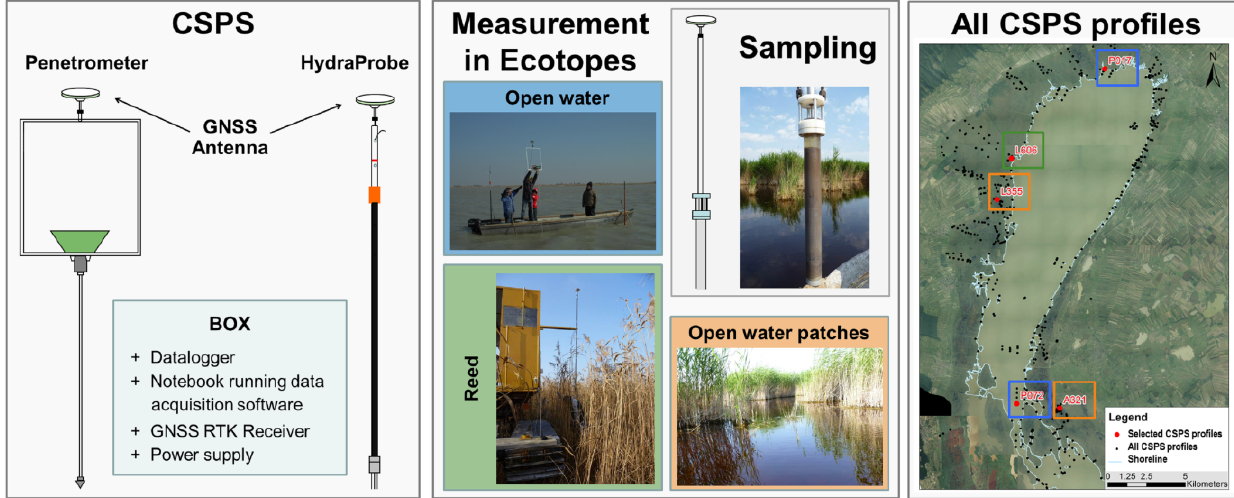
Figure 1. Overview showing the designed system (CSPS), the measurement in the different ecotopes in representative pictures, the sampling equipment, and all measured CSPS profiles at the study site, the Neusiedler See. The selected ecotope-specific CSPS profiles are shown as red